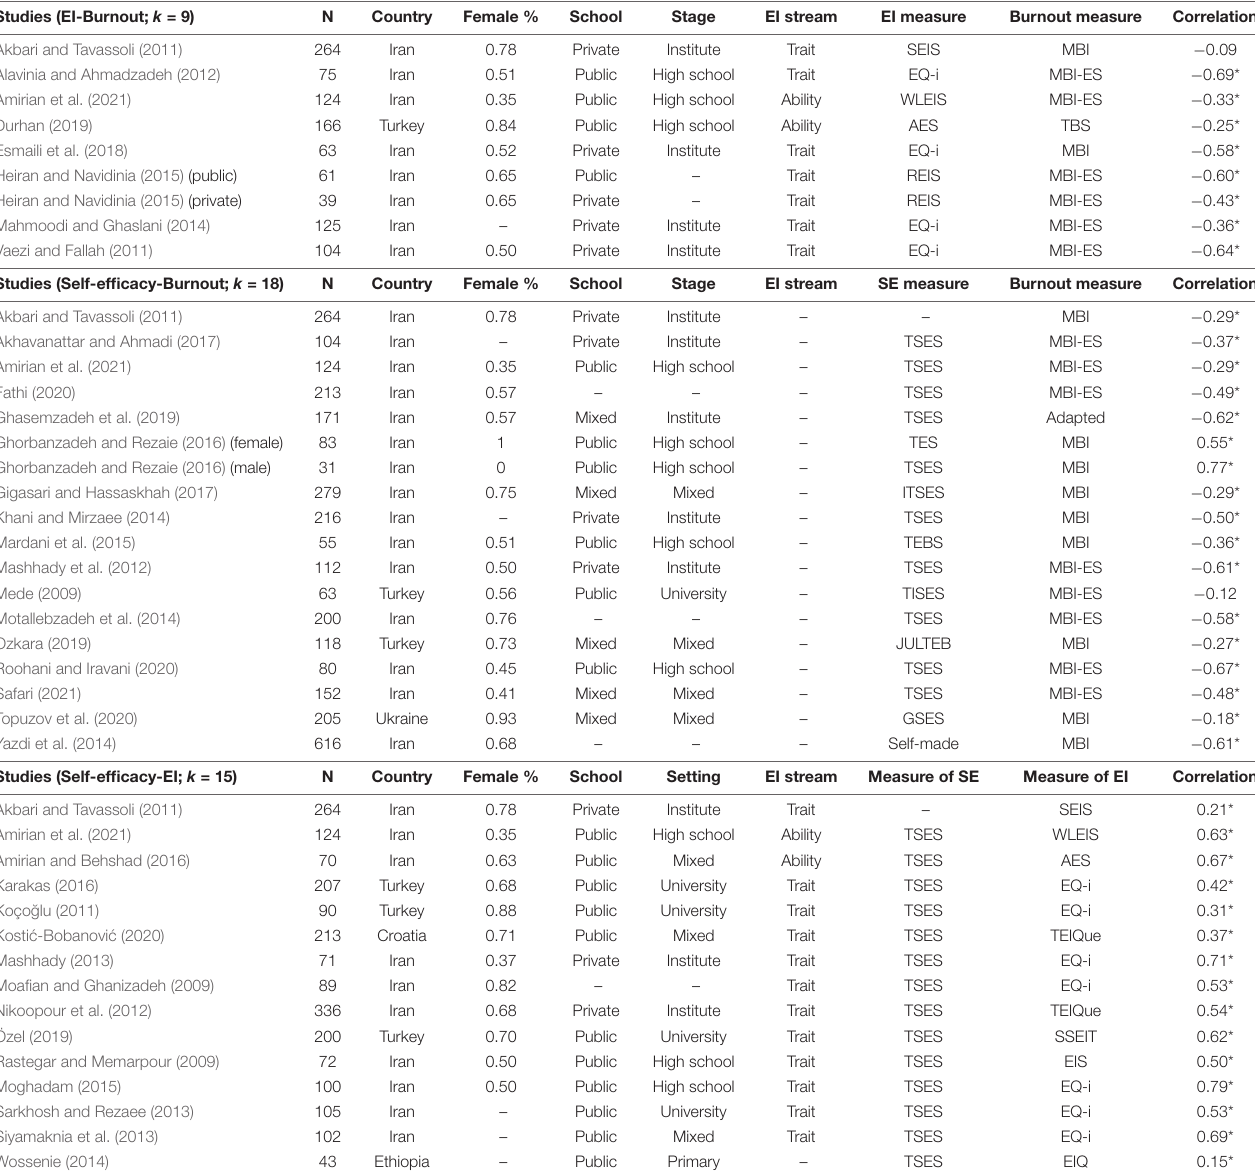
TABLE 1 | Summary of studies included in the